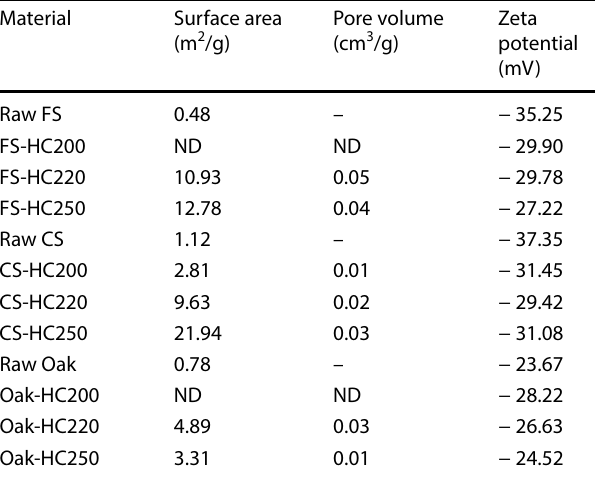
ND not determined, Raw FS non-carbonised Fucus serratus , Raw CS non-carbonised coconut shell, Raw Oak non-carbonised